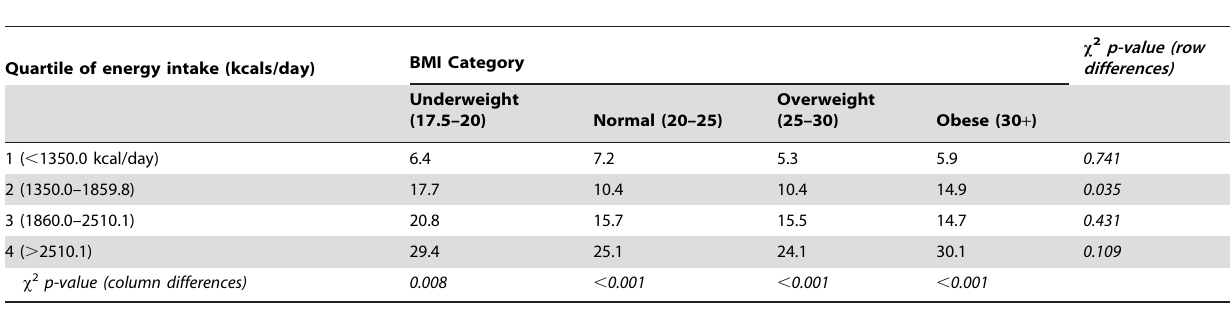
Table 1. Proportion consuming 2 + sugary sodas (cells) by quartile of energy intake (rows) and body mass index (BMI) category